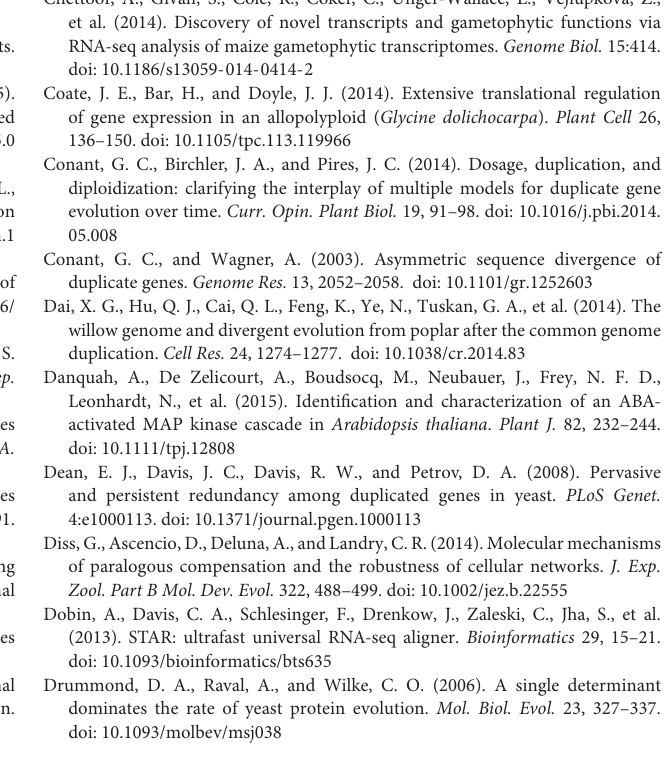
FIGURE S4 | Distribution of the value of K a / K s of the paralog copy with the higher RF abundance for WGD (A) and tandem duplicates (B) . FIGURE S5 | The database for translational divergence of plant duplicate genes. (A) Homepage of the database. (B) The ‘Search’ interface of the database. (C) An examples of the search results. TABLE S1 | Mapping information of all analyzed ribo-seq/mRNA-seq data sets. TABLE S2 | Correlation between the relative divergence of TE and the relative divergence of sequence features in CDS and UTR for WGD duplicates. TABLE S3 | Correlation between the relative divergence of TE and the relative divergence of sequence features in CDS and UTR for tandem duplicates. TABLE S4 | Sources of genomics information of plants used in the study. TABLE S5 | Correlation of the relative divergence between mRNA abundance, TE, and K s , and between RF abundance and K a / K s for WGD duplicates. The Pearson’s correlation coefficient and P -value are shown. TABLE S6 | Correlation of the relative divergence between mRNA abundance, TE, and K s , and between RF abundance and K a / K s for tandem duplicates. The Pearson’s correlation coefficient and P -value are shown. TABLE S7 | Identification of genes with differential TE across tissue types or stress conditions using RiboDiff. TABLE S8 | Gene ontology (GO) categories enriched in duplicate genes with differential TE across tissue types or stress